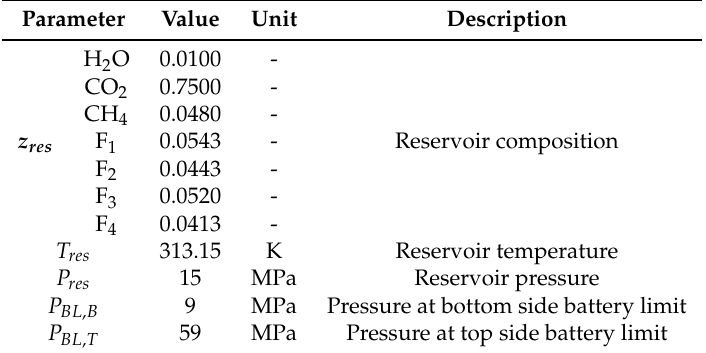
Table A2. Fixed variables used in the